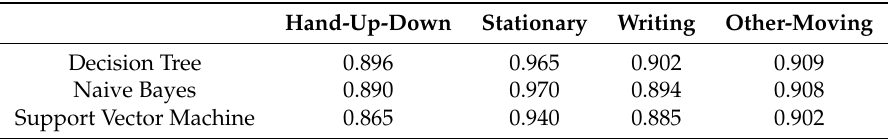
Table 4. F1 scores for different classification